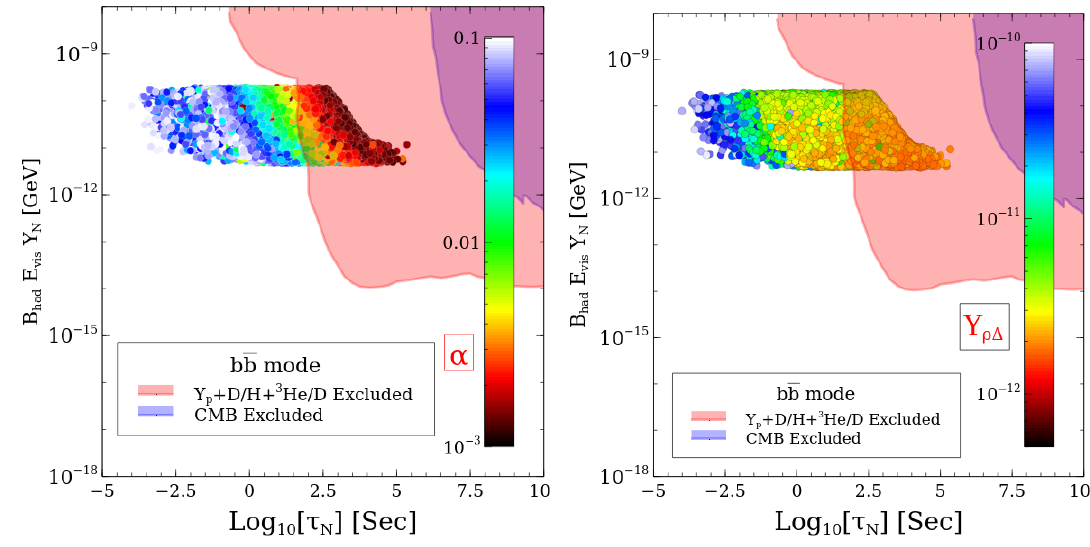
Figure 11 . Scatter plots in life time of N and injected hadronic energy through decay of N after implementing the bound from BBN. The colorbar in the LP corresponds to the variation of mixing angle whereas RP is for the Yukawa coupling. All points in the RP and LP satisfy the DM relic density constraints in 3 σ range. The red shaded region denote the BBN constraints from Y p + D/H + 4 He/D , and violet shaded region is excluded by CMB spectral distortion [32].